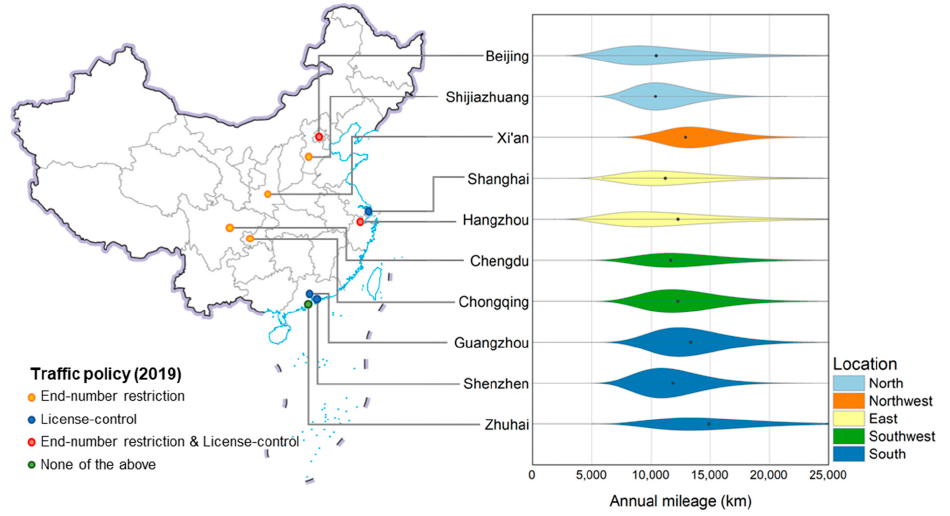
Figure 5. Annual mileage distribution of the selected 10 cities and their locations.